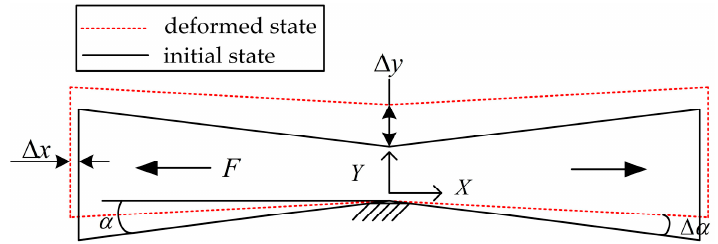
Figure 5. Force model of hourglass displacement amplification mechanism.